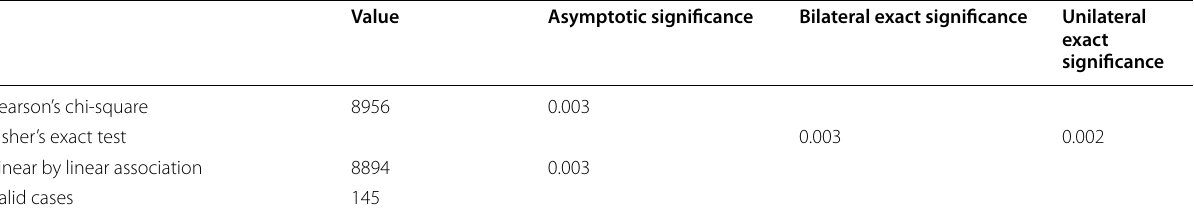
Table 3 Chi‑square and Fisher’s exact test values resulting from the cross tab analysis of recommendation of MC use for psychiatric and non‑psychiatric symptoms among psychiatrists. As long as one of the values in the cross tab is below 5, Fisher’s exact test is the preferred